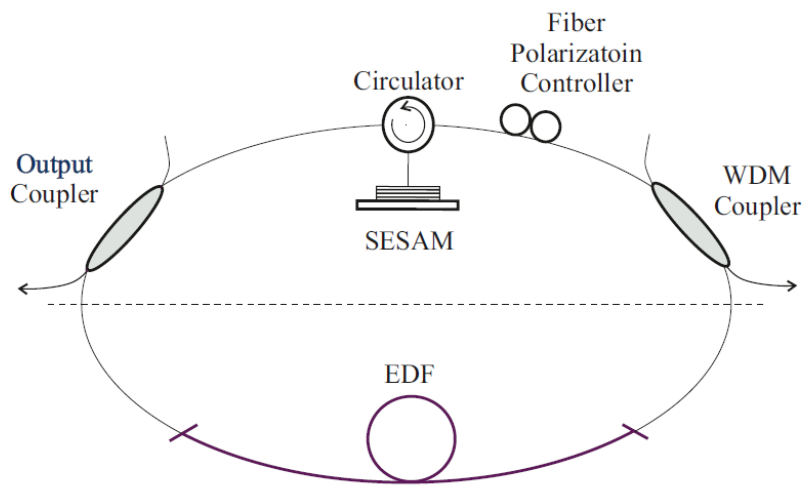
Figure 14. Ring scheme of the fiber USP lasers resonator using SESAM.